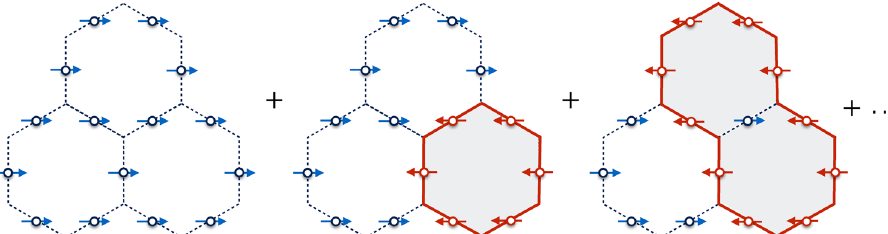
Fig. 4 Pictorial representation of the quantum spin liquid ground states of the Toric code (10). These states are massive, equal-amplitude superpositions of all possible loops (red solid lines) of spins pointing along − x (red arrows), on top of a FM background of spins pointing along + x (blue arrows)